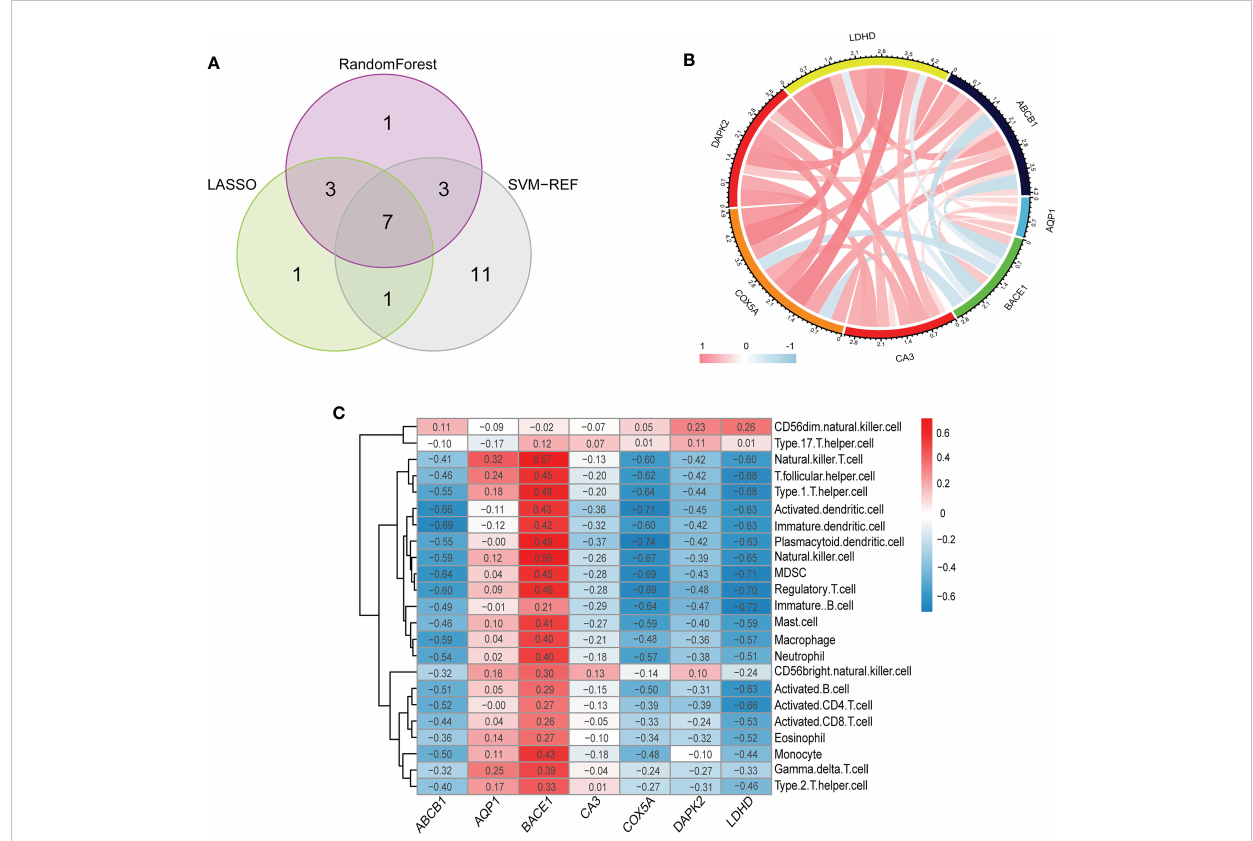
FIGURE 5 (A) The venn diagram shows the overlap of DECRGs between the three algorithms. (B) The chord diagram shows the relationship among the seven signature genes. (C) Correlation heatmap depicting the relationship between immune cell in fi ltration and signature genes. (B, C) Red indicates a positive correlation between two elements (signature gene and signature gene/signature gene and immune cells), blue indicates a negative correlation, the darker the color/the greater the absolute value of the value, the higher the